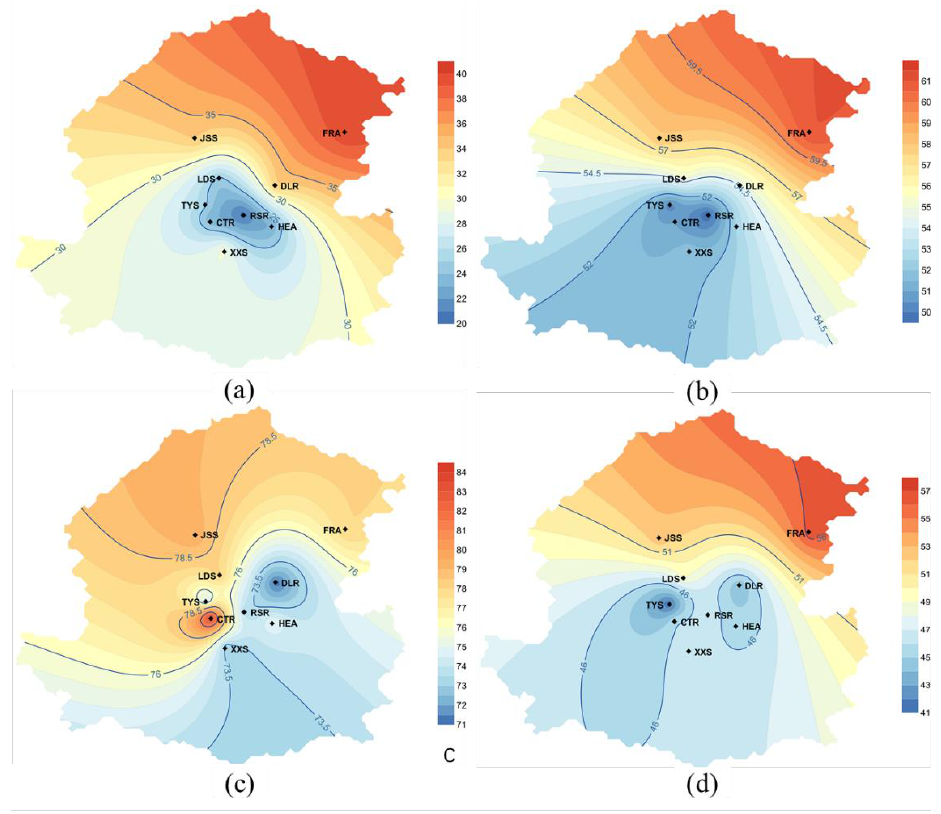
Figure 12. Spatial distribution of ozone pollution in Shenyang. ( a ) Pre-lockdown; ( b ) 2020 lockdown; ( c ) post-lockdown; ( d ) 2019 lockdown.